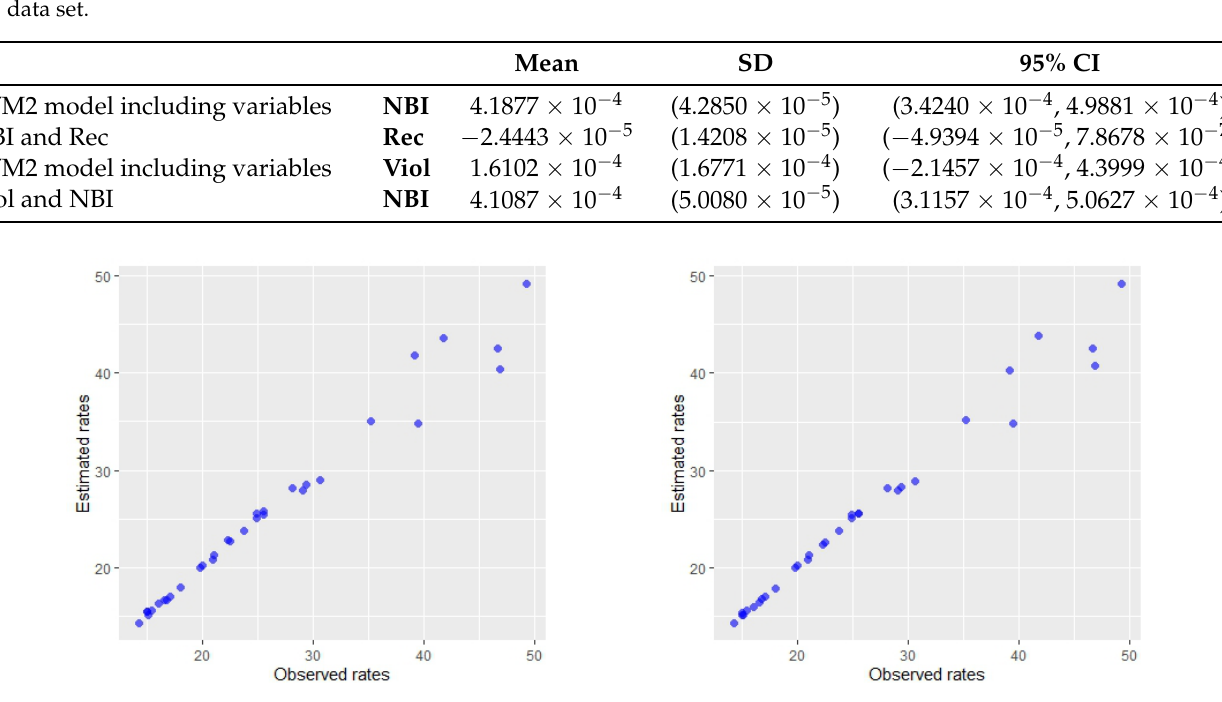
( b ) BYM2 model including variables Viol and NBI.